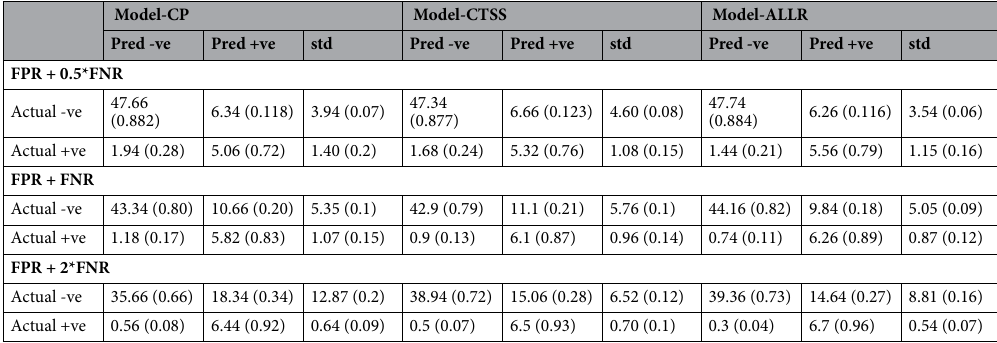
Table 3. Confusion matrices of predicting need for ventilation for validation sets of 50 iterations. The values outside the parenthesis show the number of records and the values in parenthesis are the normalized values. The confusion matrices were calculated using thresholds that minimize the cost function mentioned in the first